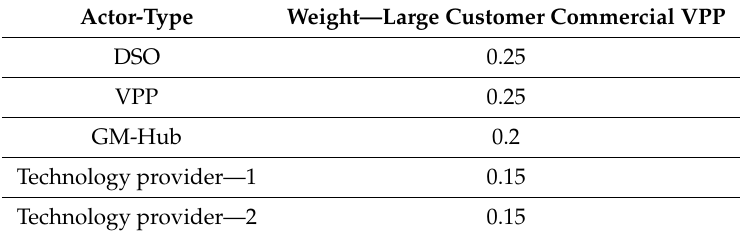
Table 5. Actors involved in the scenario under study (Large Customer Commercial VPP) and weight distribution.